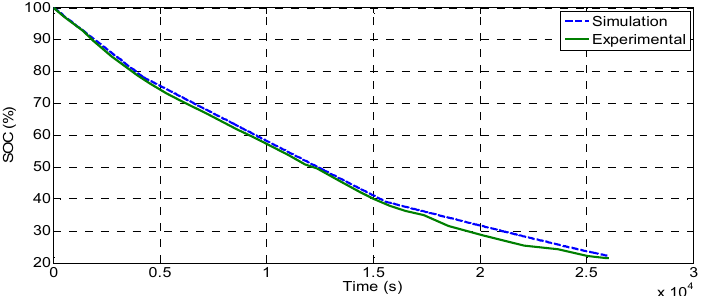
Figure 10. The SOC as a function of time at variable C rates. The SOC curve calculated by the Coulomb counting estimator is nearly a straight line (in their specific regions), i.e., the discharging test is performed individually under variable discharge currents for sustained periods (I disch = 12 A, 6 A then 3 A, respectively). It can be observed that the SOC experimental and SOC simulated are almost the same, which shows that this technique is accurate and